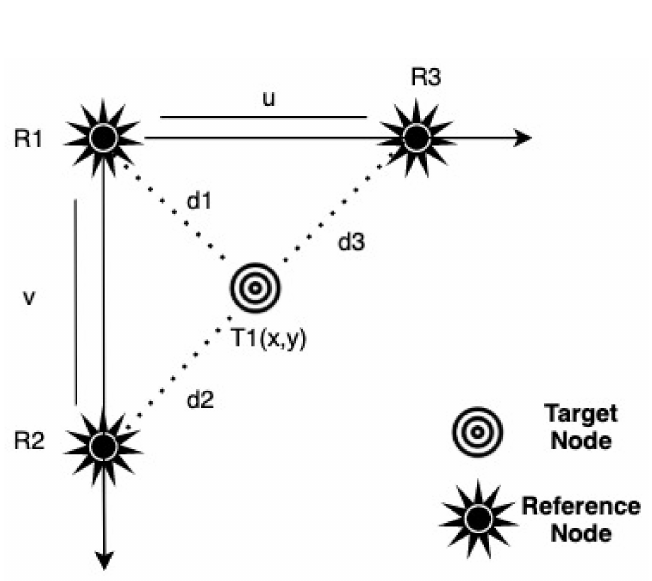
Figure 5. Trilateration with 3